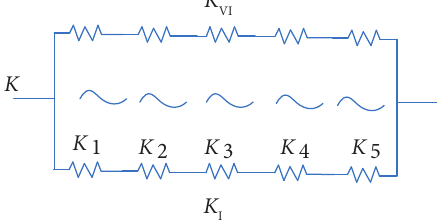
Figure 4. The equivalent stiffness of flexure